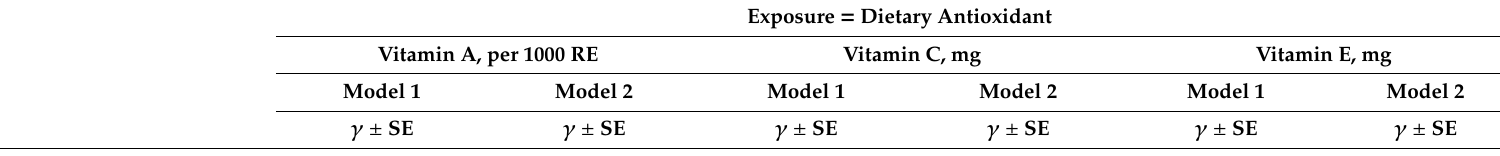
Table 2. Associations (unstandardized regression coe ffi cients) of dietary vitamins A, C, and E with cognitive performance and decline over time, across total carotenoid tertiles: Mixed-e ff ects linear regression models, HANDLS 2004–2013 a,b